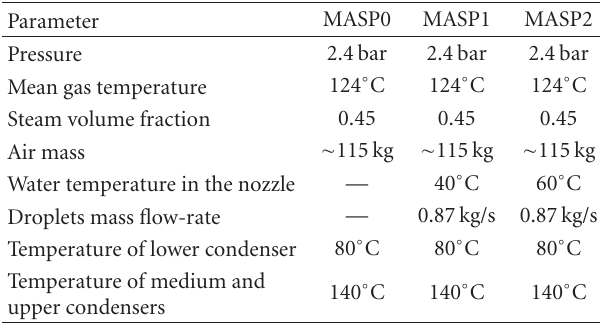
Table 1: Benchmark specifications—Part A